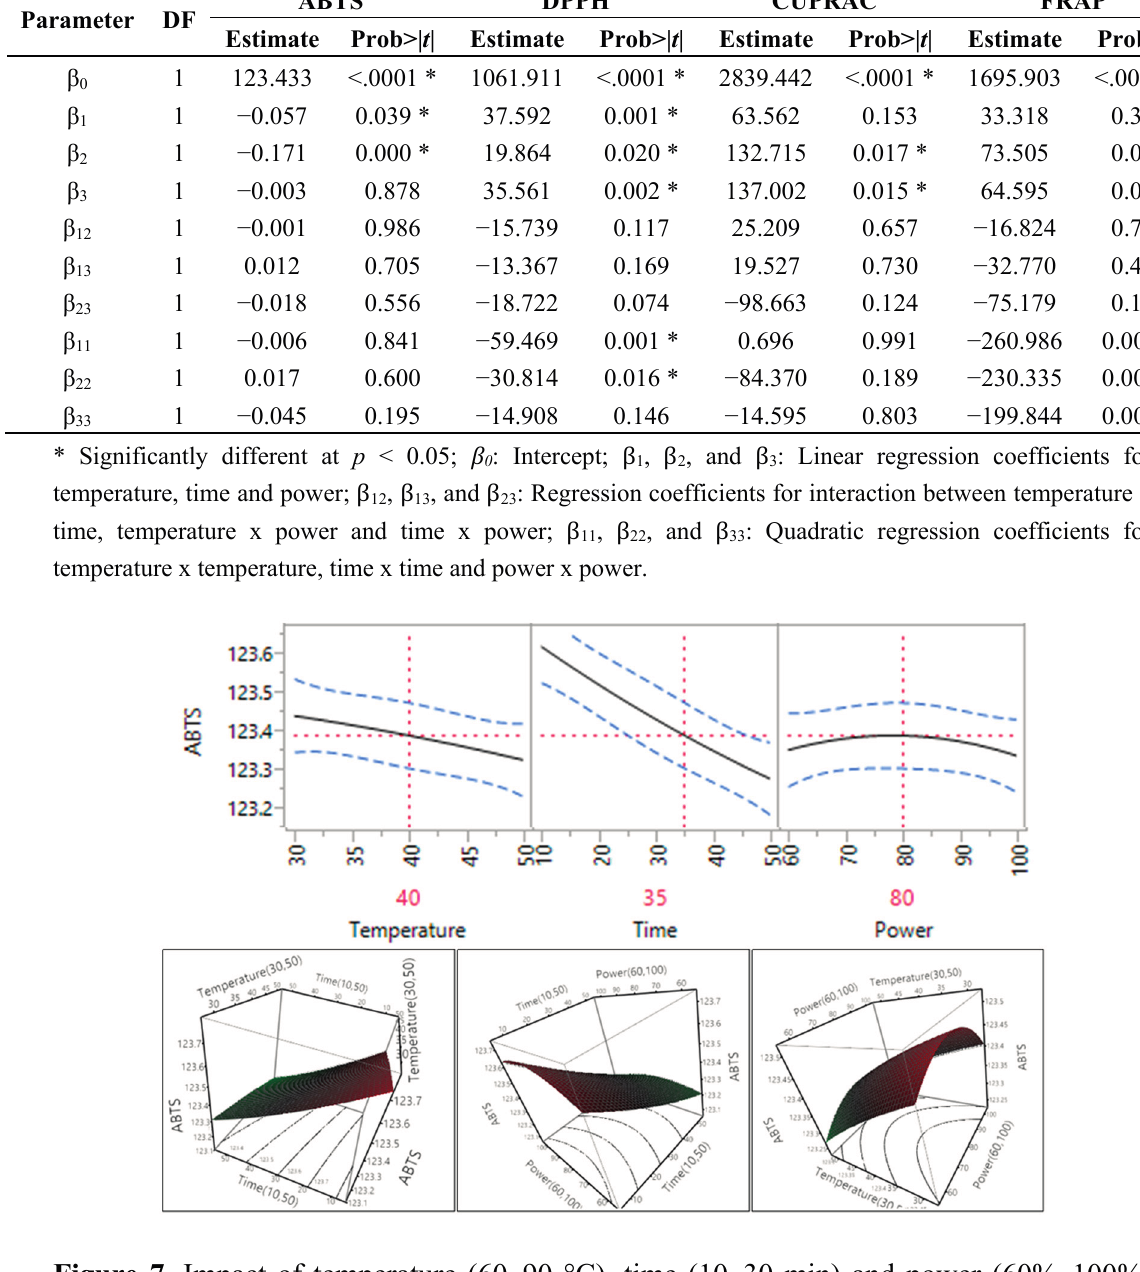
Figure 7. Impact of temperature (60–90 °C), time (10–30 min) and power (60%–100%) on